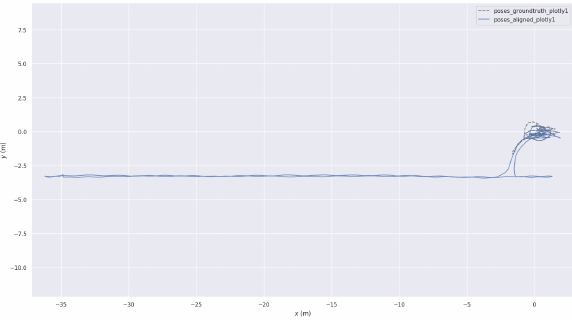
Figure 4. Trajectory of corridor 04.